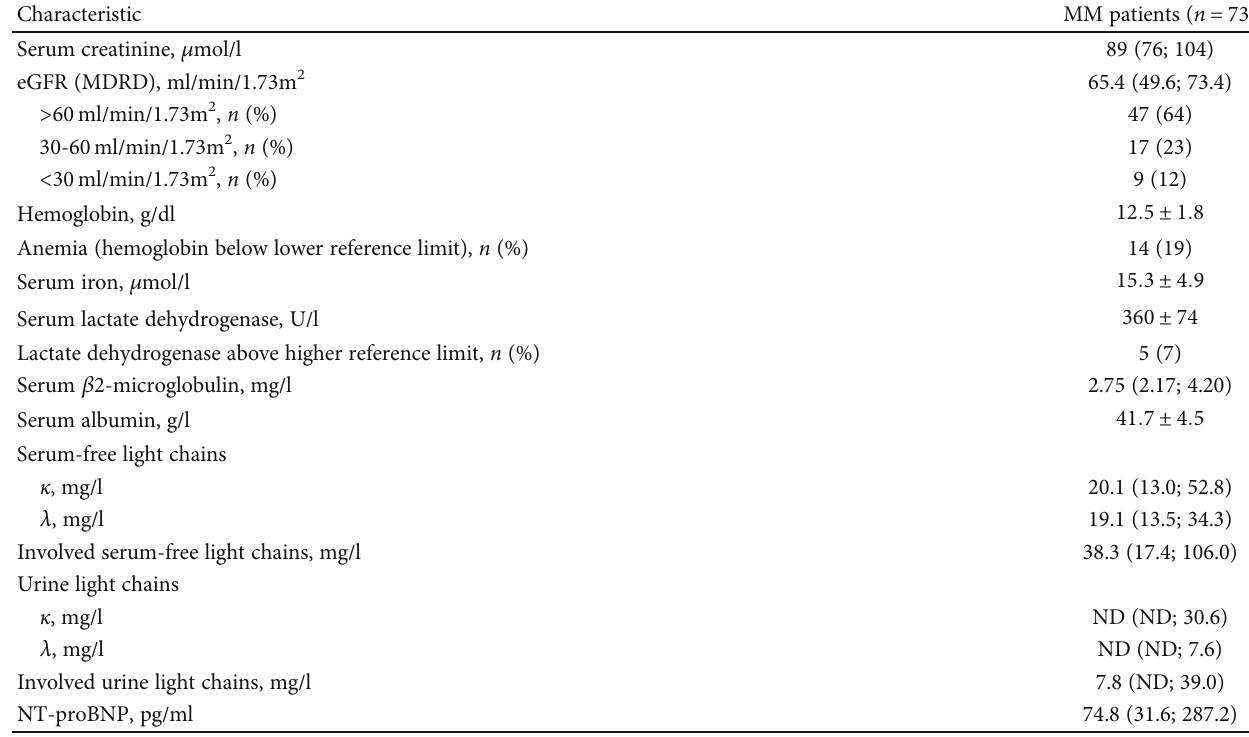
Table 3: Laboratory data of patients at baseline.